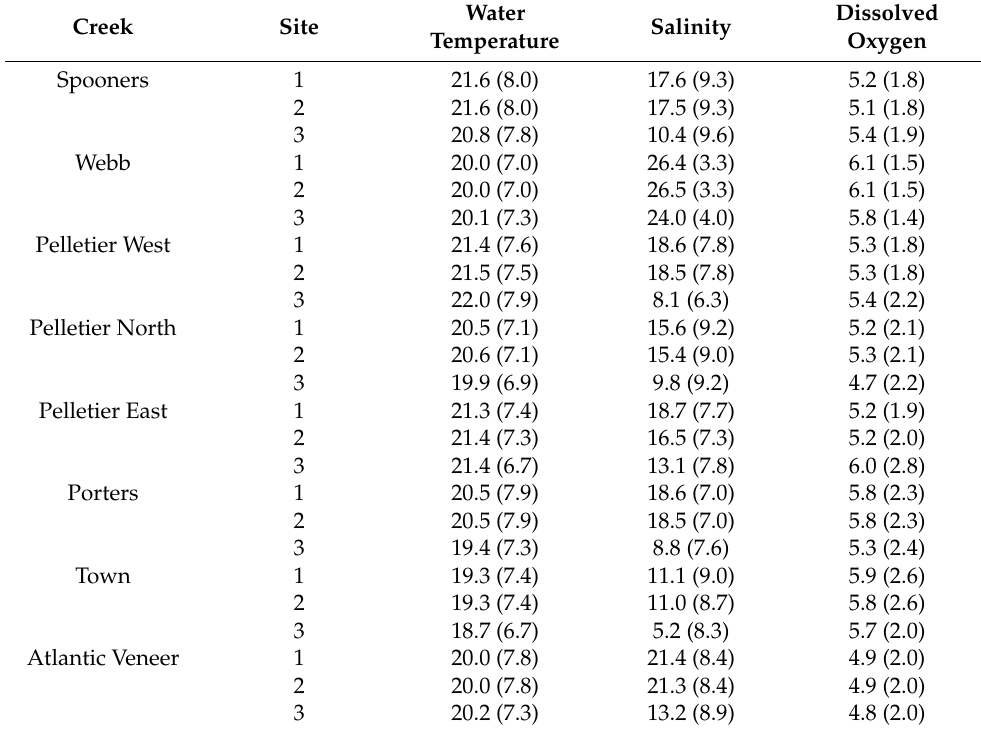
Table 3. Mean ( ± S.D.) values for water temperature ( ◦ C), salinity (parts-per-thousand), and dis- solved oxygen (mg/L) at each of the three fixed sample sites in eight first-order tidal creeks in coastal North Carolina (USA) where juvenile blue crab Callinectes sapidus occupancy dynamics were studied. Sites in each creek are numbered from lowest to highest values (1–3) in a downstream-to-upstream orientation. Creeks are tabled in order (from west to east) that they appear on the overview map (see Figure 1). Water Salinity Creek Site Temperature